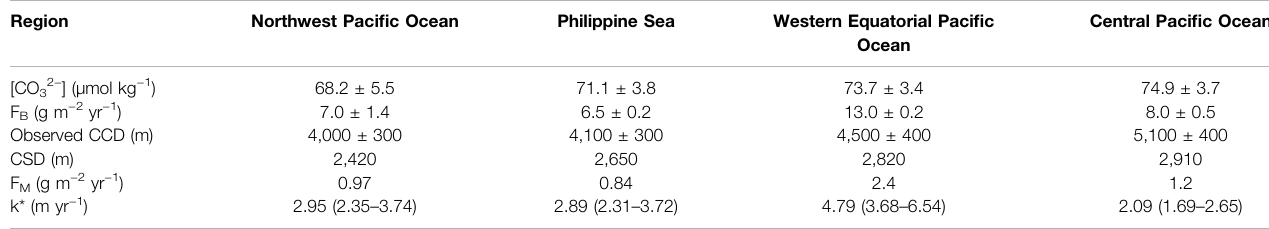
TABLE 1 | Predicted values of the carbonate saturation depth (CSD), carbonate dissolution rate (k*), and non-carbonate fl ux (F M ) obtained from parameters of PIC fl ux (F B ), [CO 32 − ] (spatial mean value ± standard deviation), and observed carbonate compensation depth (CCD) used in the control run.